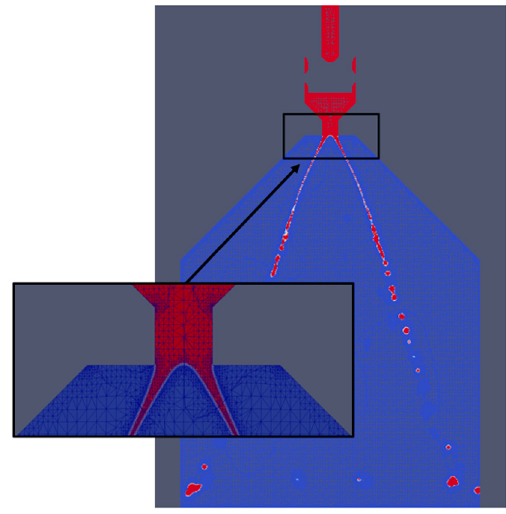
Figure 3. Adaptive mesh refinement .